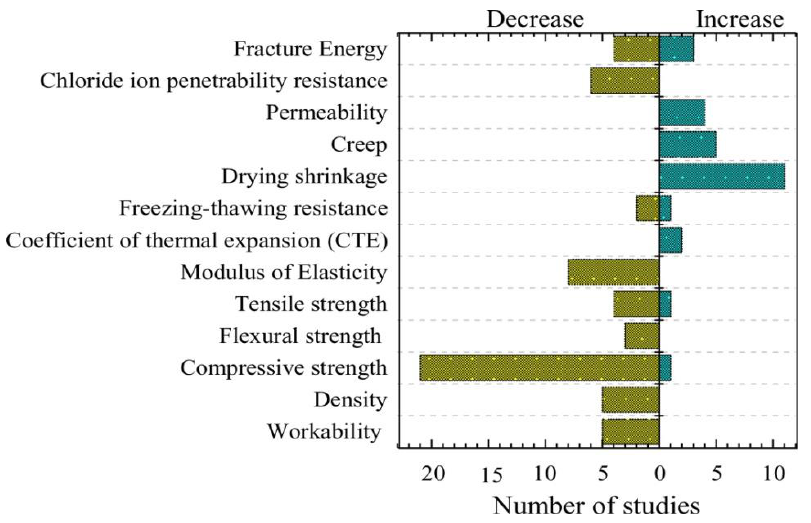
Figure 7. Influence of RCA on concrete properties. Reprinted with permission from ref. [108]. Copyright 2018 Elsevier.